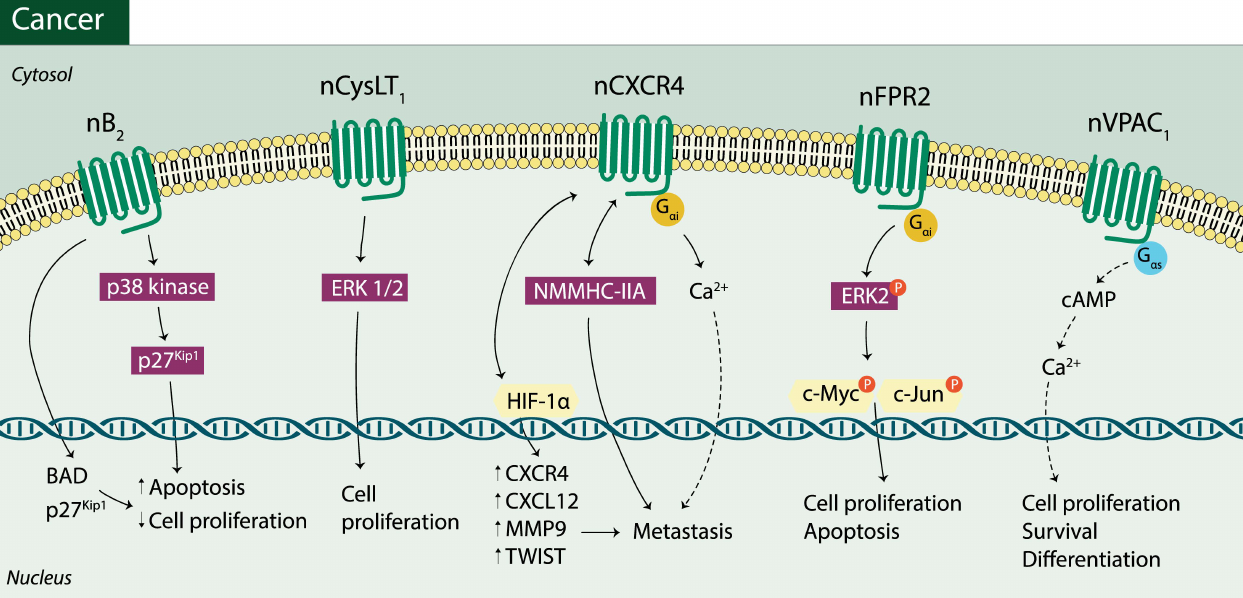
Figure 2. Atypical pathways involving nuclear GPCRs in cancer: nuclear bradykinin B type 2 (nB 2 ), nuclear cysteinyl leukotriene type 1 (nCysLT 1 ), nuclear C-X-C chemokine type 4 (nCXCR4), nuclear N-formyl peptide type 2 (nFPR) and nuclear vasoactive intestinal peptide type 1 (nVPAC 1 ) receptor activated signaling pathways. Table 2. Differential expression between nuclear and plasma membrane GPCRs in physiological and pathophysiological conditions. Receptor Nuclear Membrane Plasma